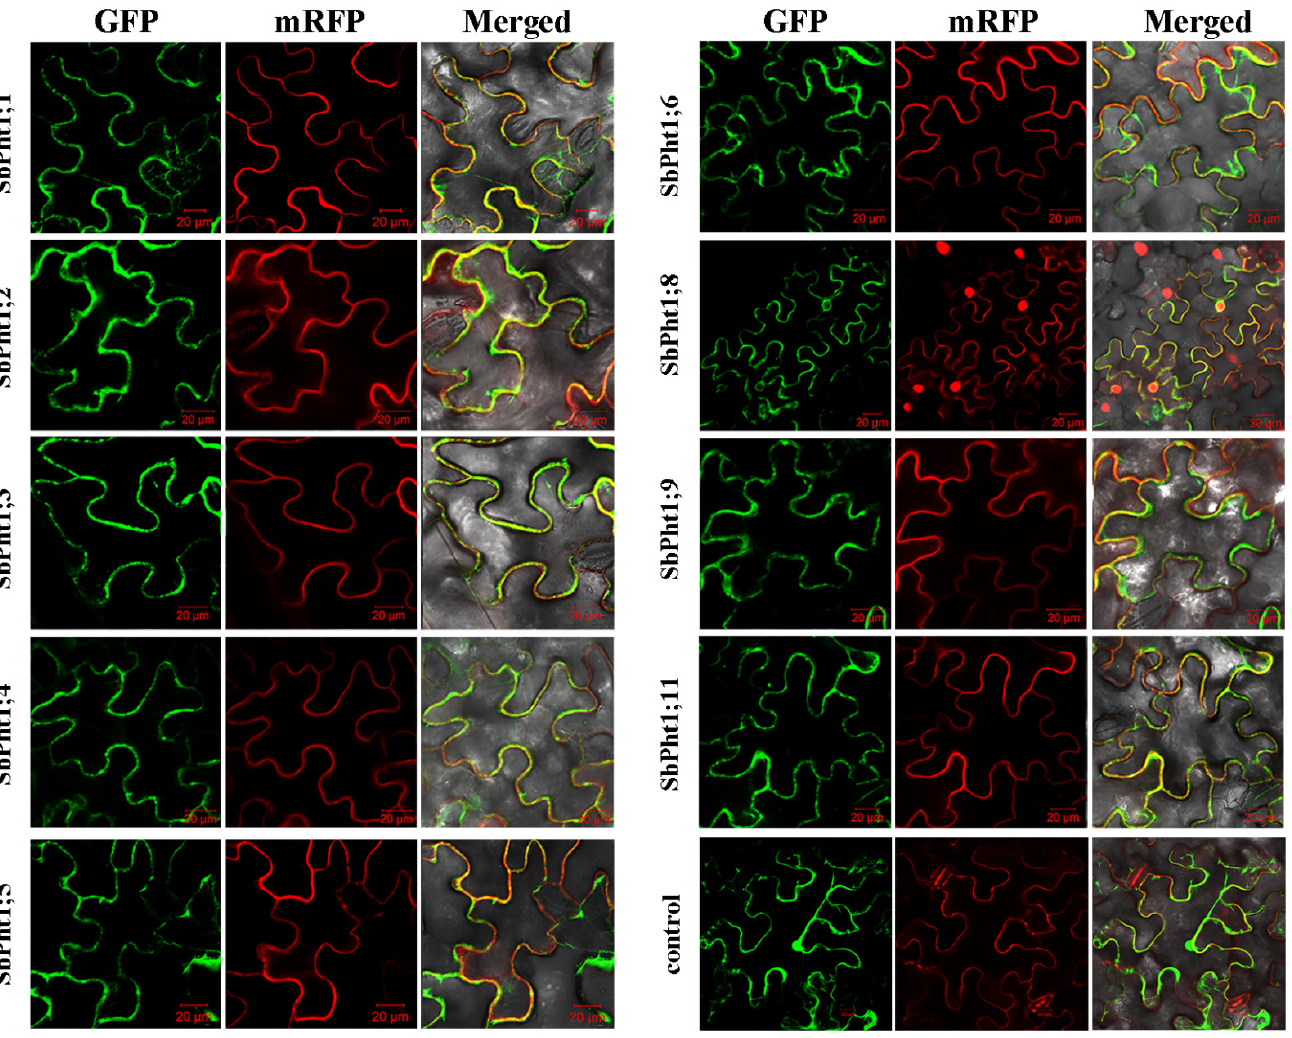
Figure 4. Subcellular localization of SbPht1s. SbPht1;1-GFP, SbPht1;2-GFP, SbPht1;3-GFP, SbPht1;4-GFP, SbPht1;5-GFP, SbPht1;6-GFP, SbPht1;8-GFP, SbPht1;9-GFP, and SbPht1;11-GFP. The fluorescence signals overlapped with the signal of the mRFP cell membrane marker.